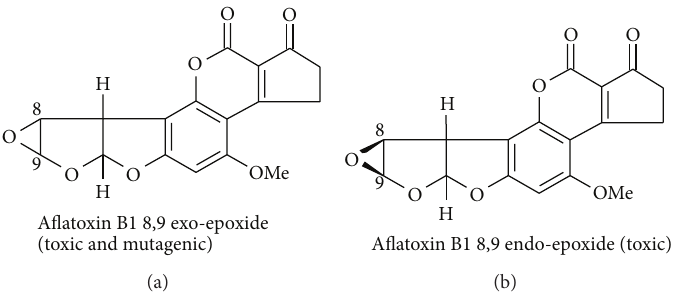
Figure 2: Structures of the two major aflatoxin B1 epoxides. The exo-epoxide is both toxic and carcinogenic; the endo-epoxide is only